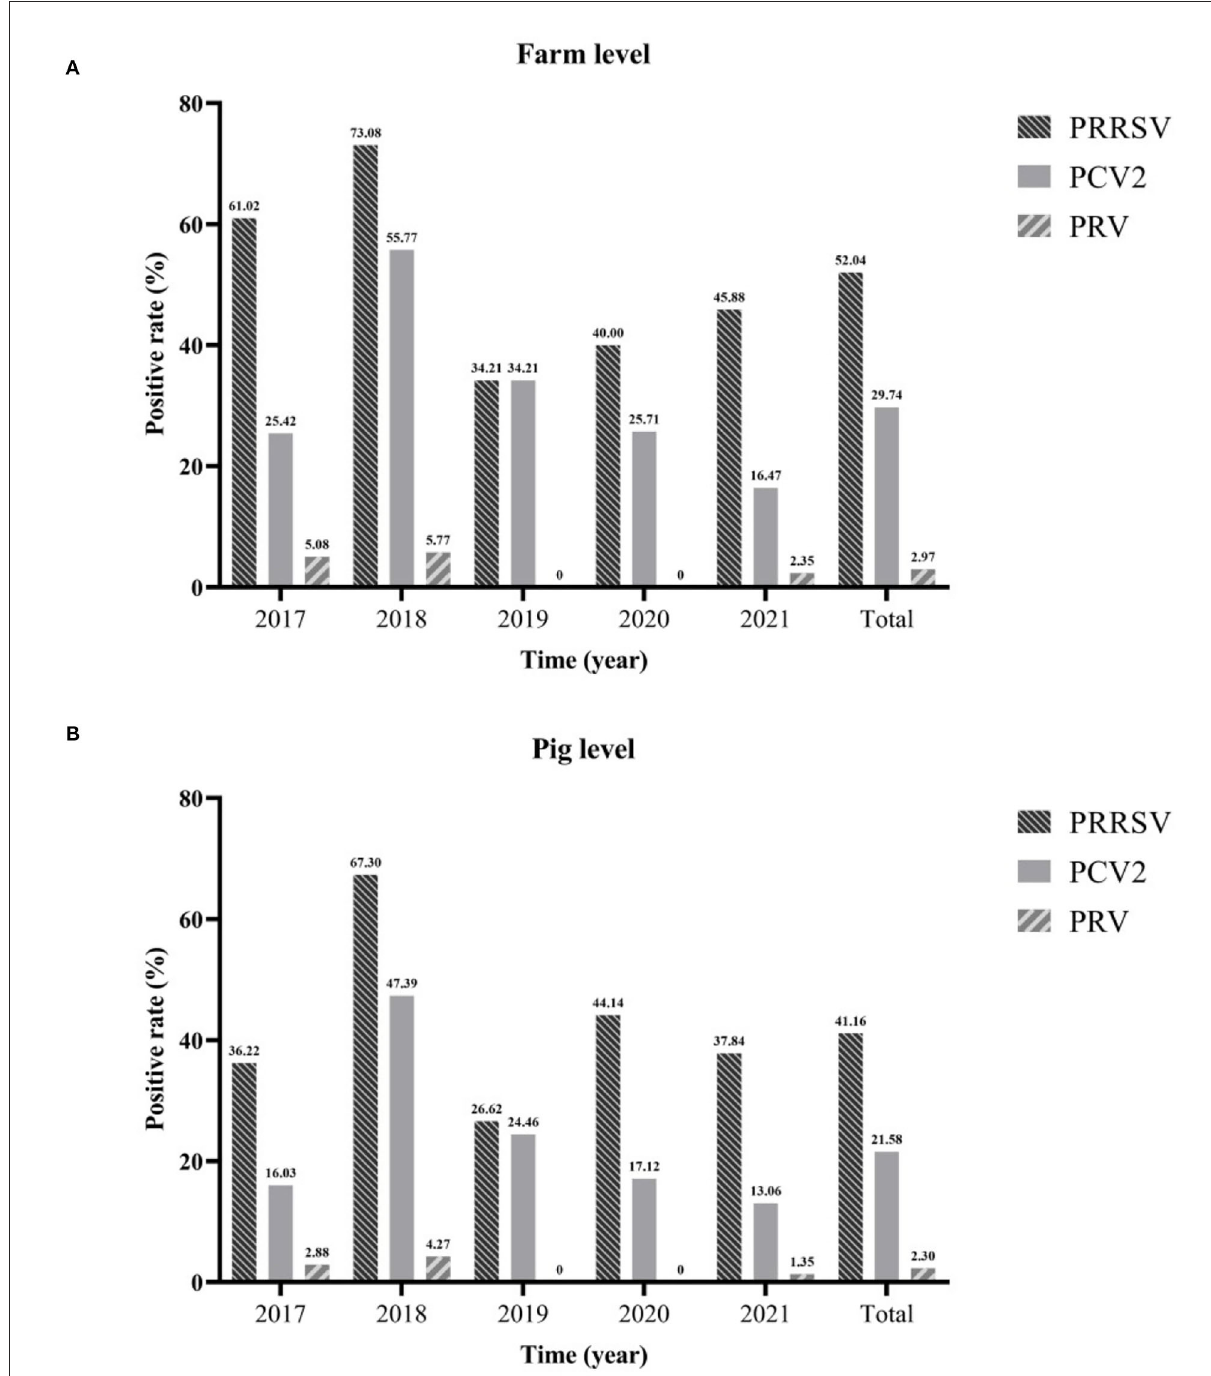
FIGURE1 The positive rate of different viruses from 2017 to 2021. Farm level (A) and pig level (B) .